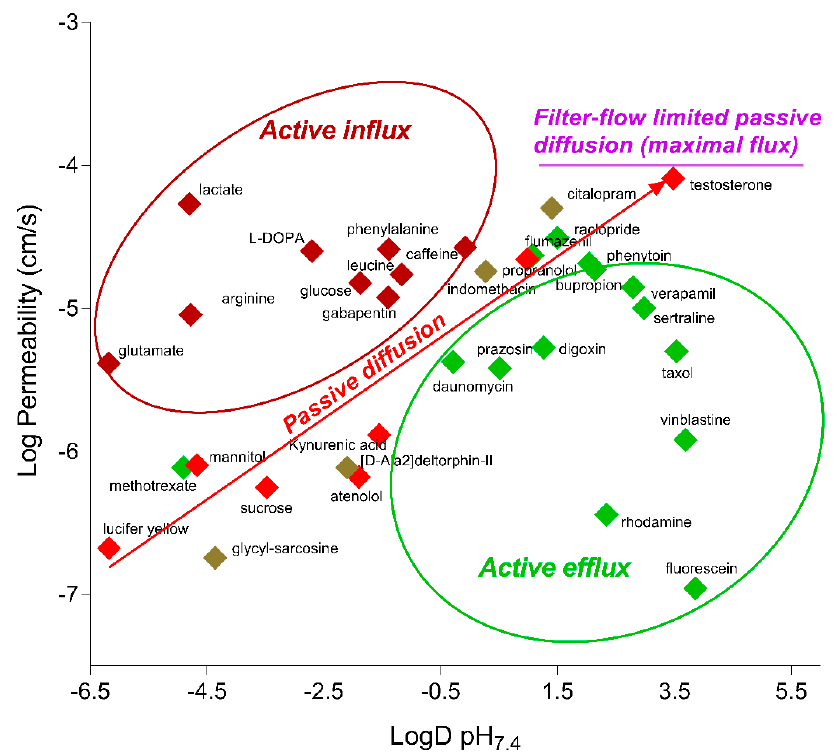
Figure 6. The Log Permeability values for tested compounds in iBMEC_33Q, plotted against their corresponding Log D pH 7.4 values.